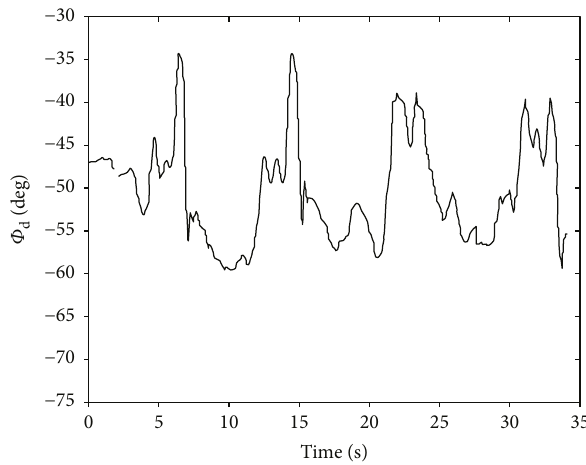
Figure 11: The joint angle ϕ parameter (ABD). 3 .